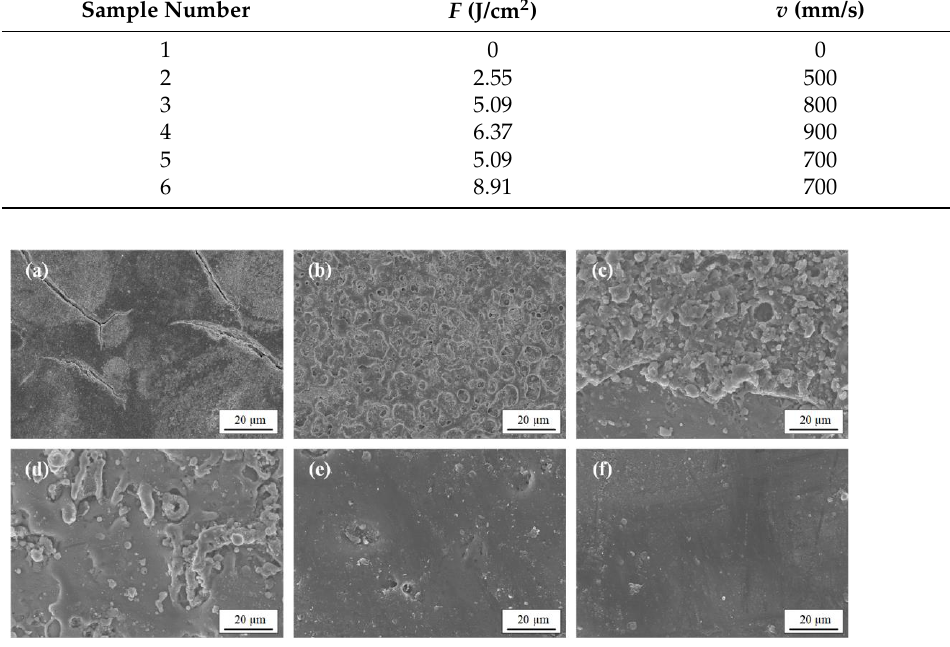
Table 3. The design scheme of the experimental factors and levels.